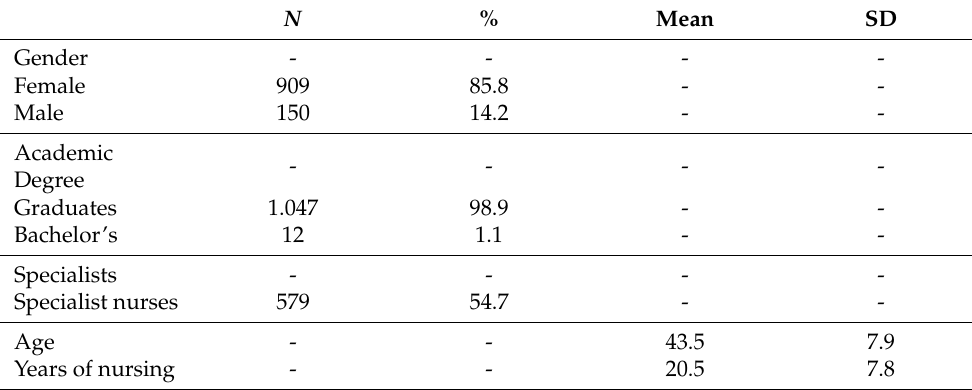
Table 1. Descriptive analysis of the demographic characteristics